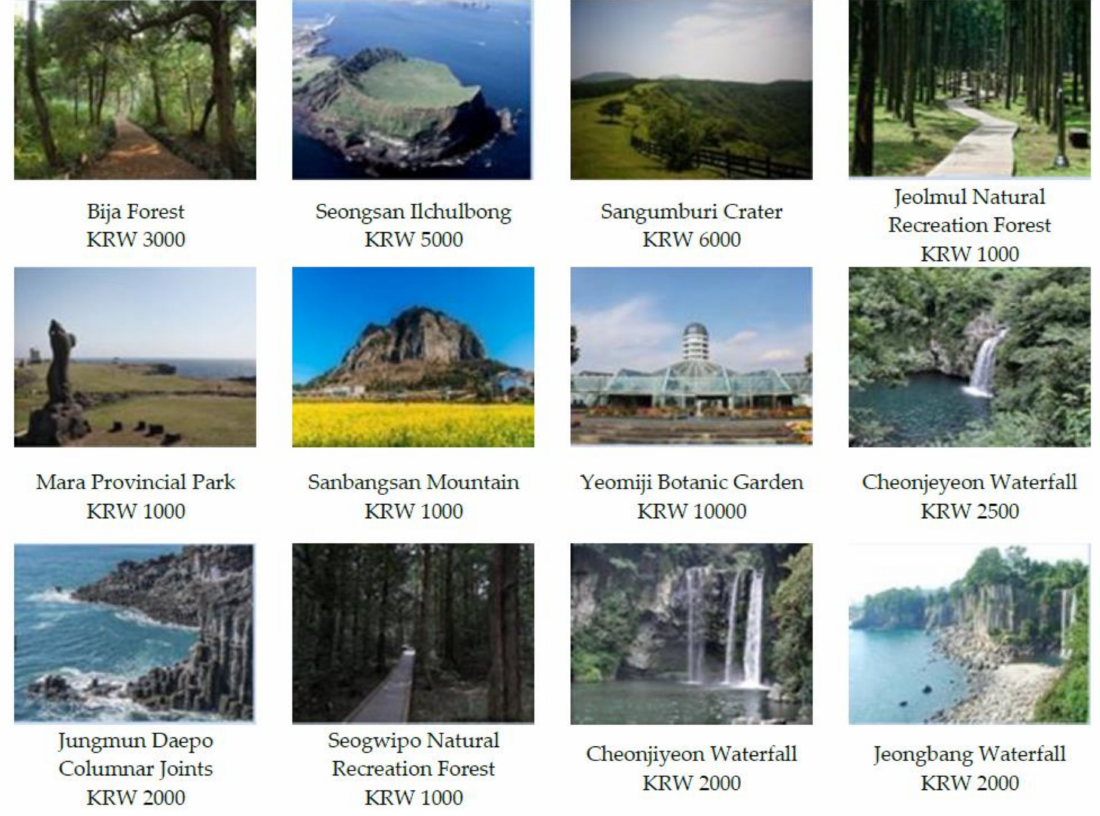
Figure 4. Admission fees for 12 tourist destinations on Jeju.